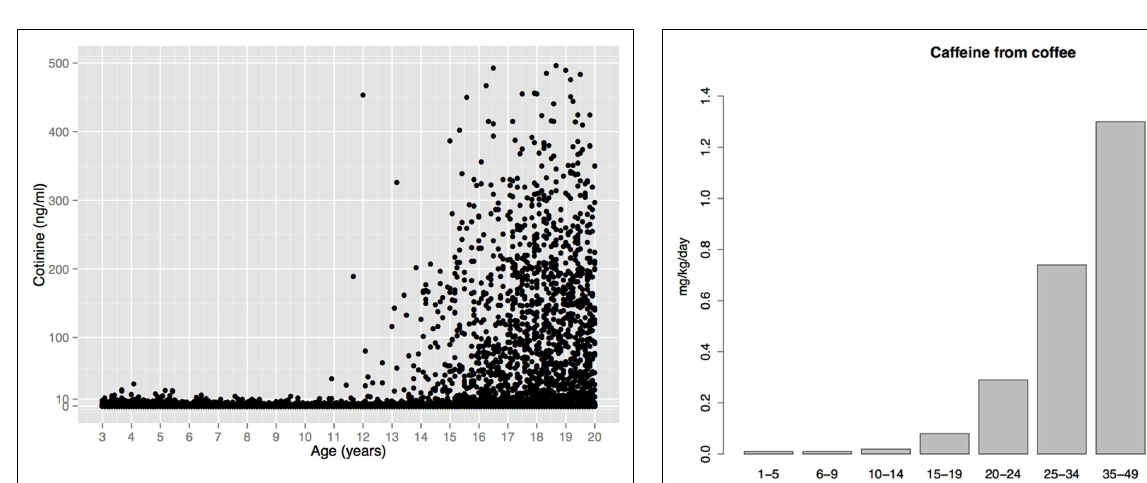
FIGURE 2 | Serum cotinine concentration vs. age in a sample of 18,382 children, adolescents, and young adults from the US National Health and Nutrition Examination Survey 1999–2010 .There is no unequivocal evidence of tobacco consumption prior to age 11. (6 Cotinine values > 500ng/ml were omitted for clarity, all from individuals > 17years old.) Data from Ref. (123).